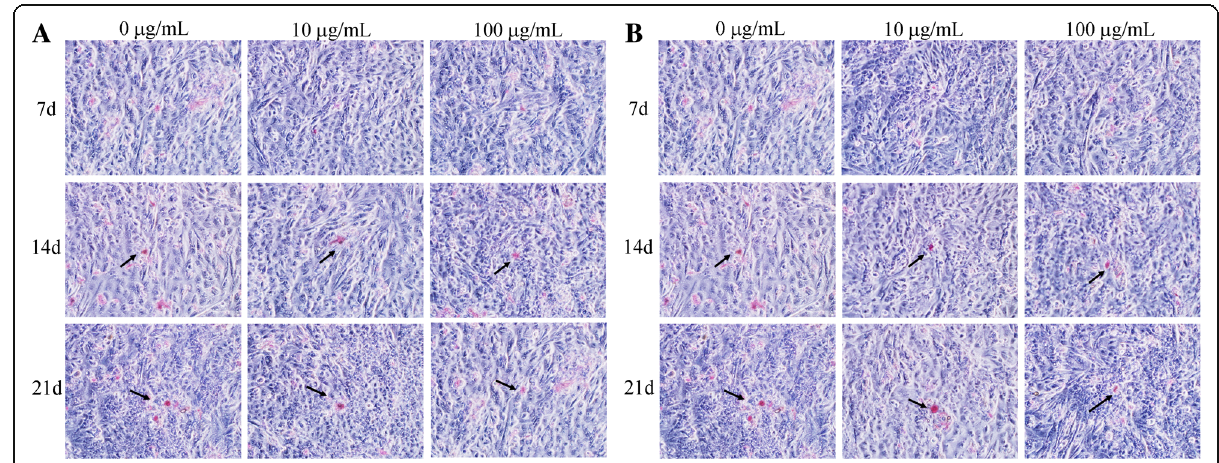
Fig. 7 TiO 2 and ZrO 2 NP-induced mineralization effects in 3T3 cells. After the 3T3-E1 cells were differentiated using mineralized solution for 7 d, 14 d and 21 d, accompanied with TiO 2 ( a ) and ZrO 2 NPs ( b ) at various concentrations. The alizarin red staining was used to detect the mineralized nodule (black